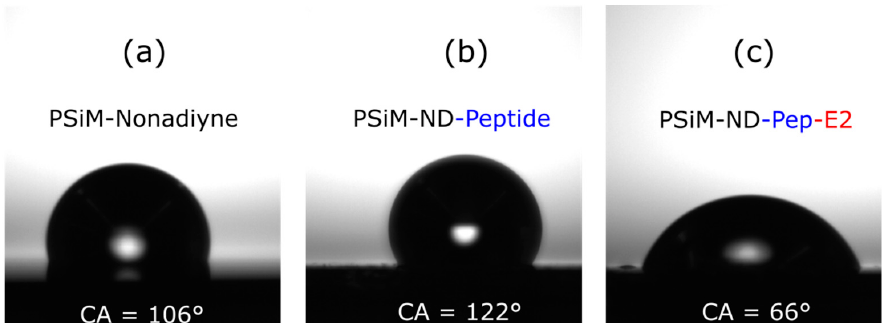
Figure 3. Surface wettability . Water droplets and their contact angles on ( a ) nonadiyne (ND)-modified PSi microcavity (PSiM); ( b ) peptide-ND-modified PSiM; and ( c ) peptide-ND-modified PSiM after E2 protein capture. Water contact angles greater than 90° after ND and peptide attachment indicate a hydrophobic surface that can hinder wetting of the PSi surface, which therefore impedes molecular diffusion into the pores. The lower contact angle after E2 protein exposure indicates that the PSi surface became hydrophilic and is further confirmation of the successful capture of the E2 protein by the PSi sensor.